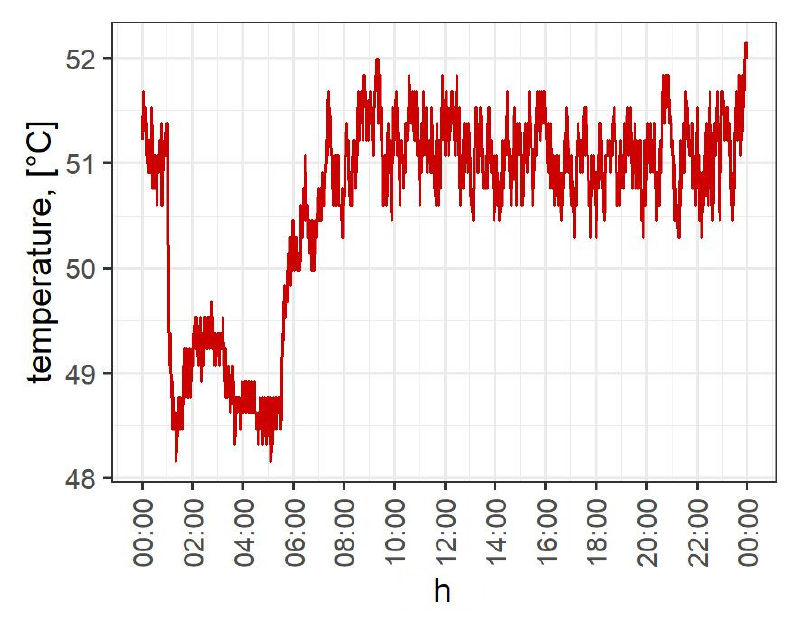
Figure 7. The course of domestic hot water temperature on a weekend day—power supplied from a heating